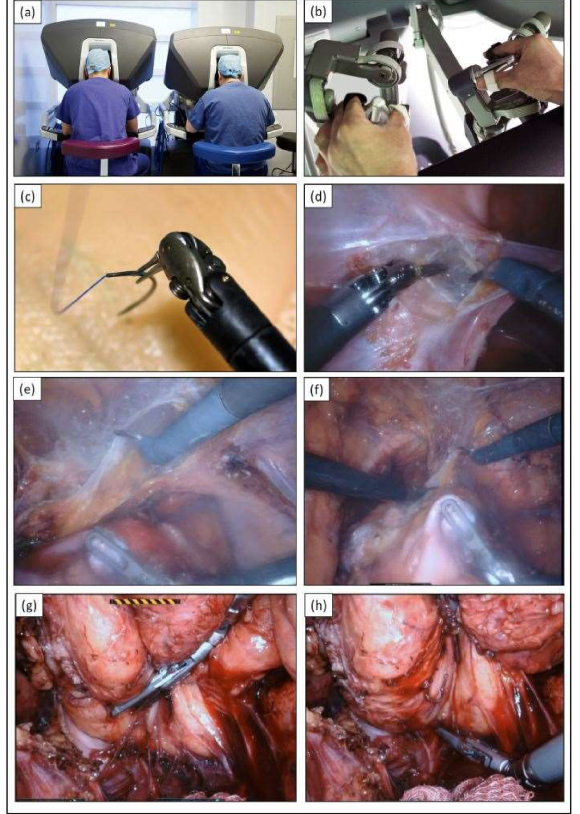
Figure 1. Images of da Vinci ® Surgical System being used in beyond-TME multivisceral pelvic exenteration surgery. ( a ) The da Vinci Xi robot dual console, which allows consultants to supervise trainees during live surgery; ( b ) EndoWrist ® technology that allows fully wristed dexterity; ( c ) The articulated ends of robotic instruments; ( d ) Pelvic side wall fascia dissection using the robotic instruments with 3D augmentation; ( e , f ) Retropubic mobilisation of the bladder facilitated by its articulated ends; ( g ) Enhanced retraction of the rectum along its posterior wall; ( h ) Utility of the articulated ends in deep pelvic